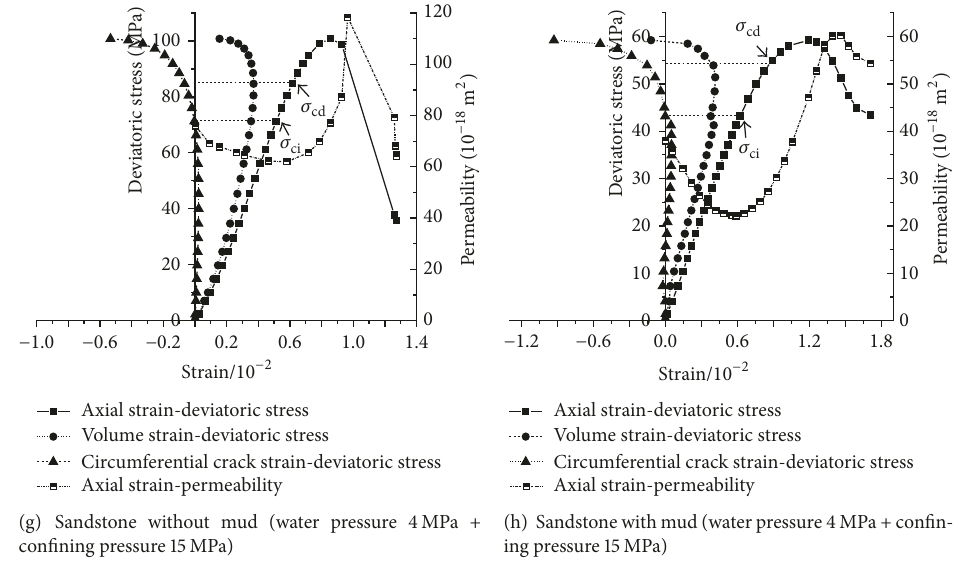
Figure 5: Gradual-cracking process and permeability behavior considering different confining pressure and water pressure.